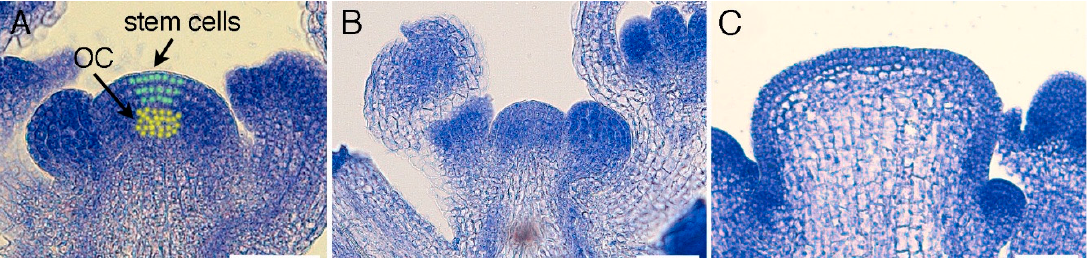
Figure 1. Shoot apical meristems of Arabidopsis wild-type and clv3 mutant plants during the inflorescence phase. ( A ) Key domains within the shoot apical meristem. The apical stem cells are colored in green and the underlying organizing center (OC) cells in yellow. Primordia arise as dome-shaped structures on the meristem flanks. ( B ) Wild-type Columbia-0 inflorescence meristem (IFM) and flanking floral meristem primordia. ( C ) Enlarged clv3 null mutant IFM and flanking floral meristem primordia. Scale bars, 50 μ m.